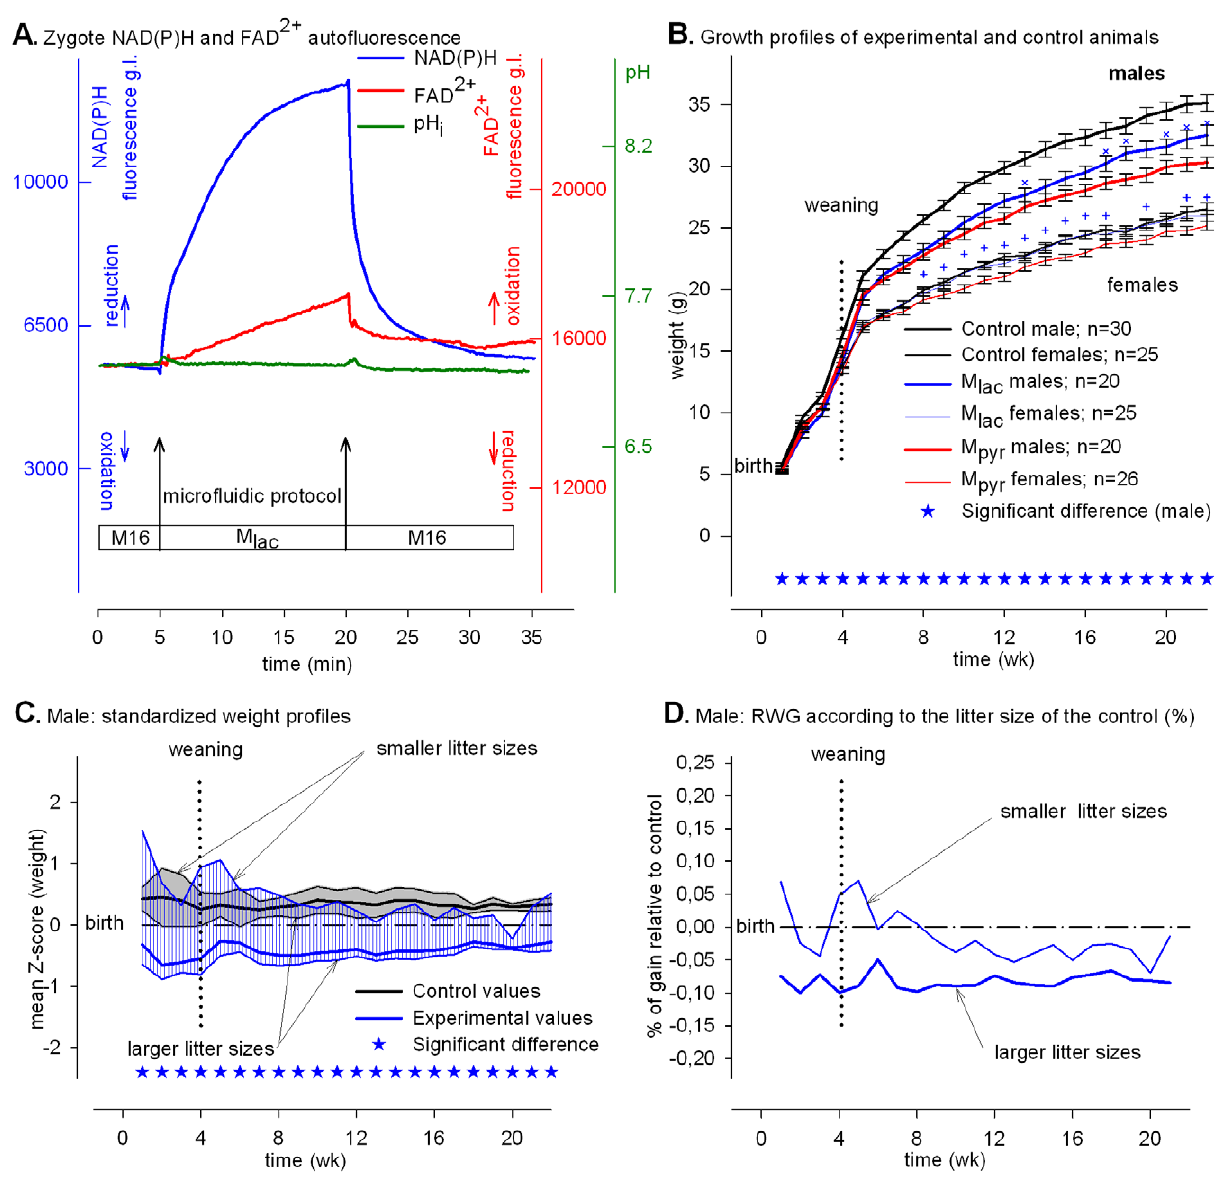
Figure 3. Exogenous lactate and developmental responses. Metabolic profiles and post-natal phenotypes induced by ‘‘Lactate.’’ ( A ) Time course of intracellular NAD(P)H (blue), FAD 2 + (red) signals (grey levels, g.l., 14 bits) and pH i fluorescence (green) of eggs subjected to M lac . ( B ) Growth profiles of control and experimental animals. The growth profiles of M pyr animals from Fig. 2B are plotted as red lines for comparison. The blue crosses and plus symbols show when the M lac profiles are significantly higher than the M pyr profiles for males and females, respectively. The data are expressed as mean 6 SEM. ( C ) Standardized plots of total Z values (n=210). The upper limits of the shaded zones (grey for the controls and blue for the experimental values) are the normalized weigh profiles of males issued from the larger litter sizes (8, 7 and 6) and the lower limits from the smaller litter sizes (5, 4, 3 and 2). ( D ) Relative weight gains (RWG) of experimental animals according to the larger or smaller litter size group.